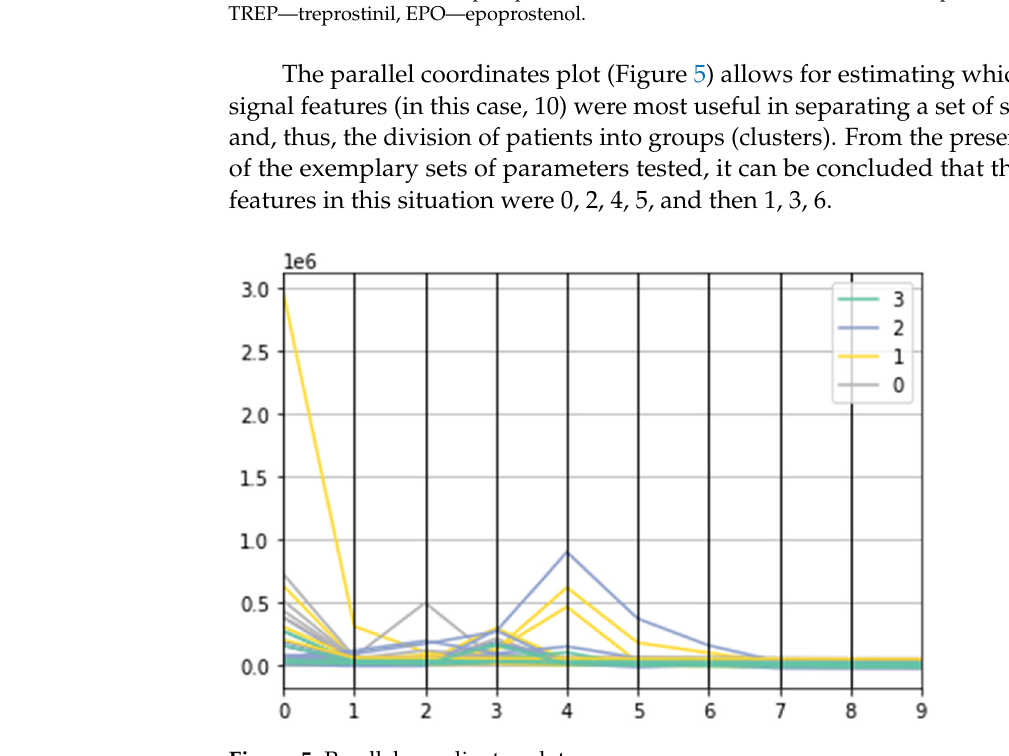
specific color, as shown in the